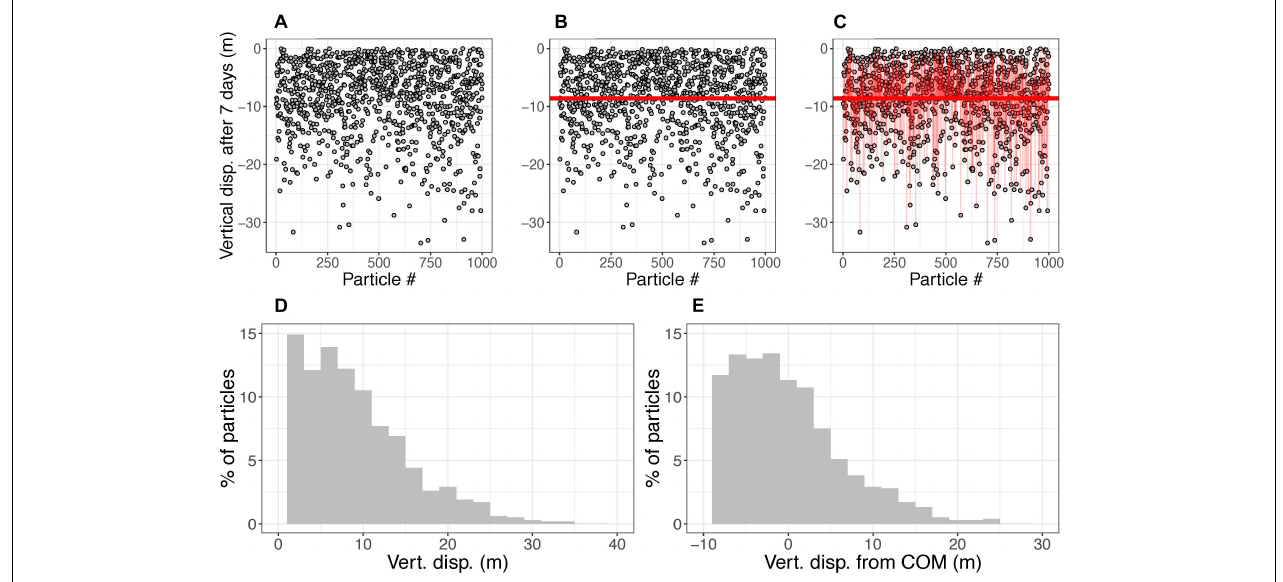
FIGURE 3 | Demonstration of vertical displacement and spread calculations. The demonstration uses a 1000-particle subset of the 10,000 used in a sample simulation. (A) The gray circles show the location of particles (released from surface) after being subject to ocean currents for 7 days. (B) The horizontal line shows the vertical center of mass (COM) of particles after 7 days. Panel (C) the thin vertical red lines show the distance from each particle to the COM. (D,E) histograms of displacement of particles and displacement of particles from the COM, respectively, of the 1000 particles in this simulation at 7 days. The vertical displacement metric is defined as the displacement of the COM, which changes in time. The vertical spread metric is calculated as the standard deviation of particle displacements, which also changes in time. For plotting results, the positive and negative spread are separated. For the statistical models, the spread is calculated as one standard deviation accounting for both the positive and negative variances. For this demonstration, at t = 7 days, the vertical displacement is –8.6 m and spread is 2.4 m in the negative direction, 5.1 m in the positive direction, and 3.9 m considering both